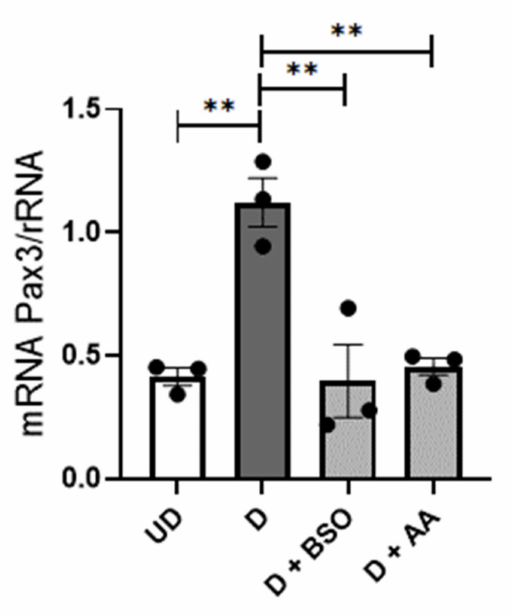
Figure 5. Inhibiting GSH synthesis in ESC-derived neuronal precursors inhibits Pax3 expression. Real time reverse transcription-PCR of Pax3 mRNA relative to rRNA from undifferentiated (UD) ESC and differentiating neuronal precursors (D) following four days of culture without or with 0.25 mM buthionine sulfoximine (BSO) or 0.001 µ M antimycin A (AA). Data shown are the mean + SEM from triplicate culture dishes. ** p <